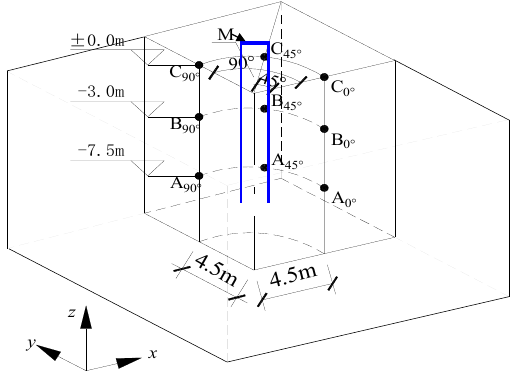
Figure 7. Observation points of acceleration in soil and pile top.